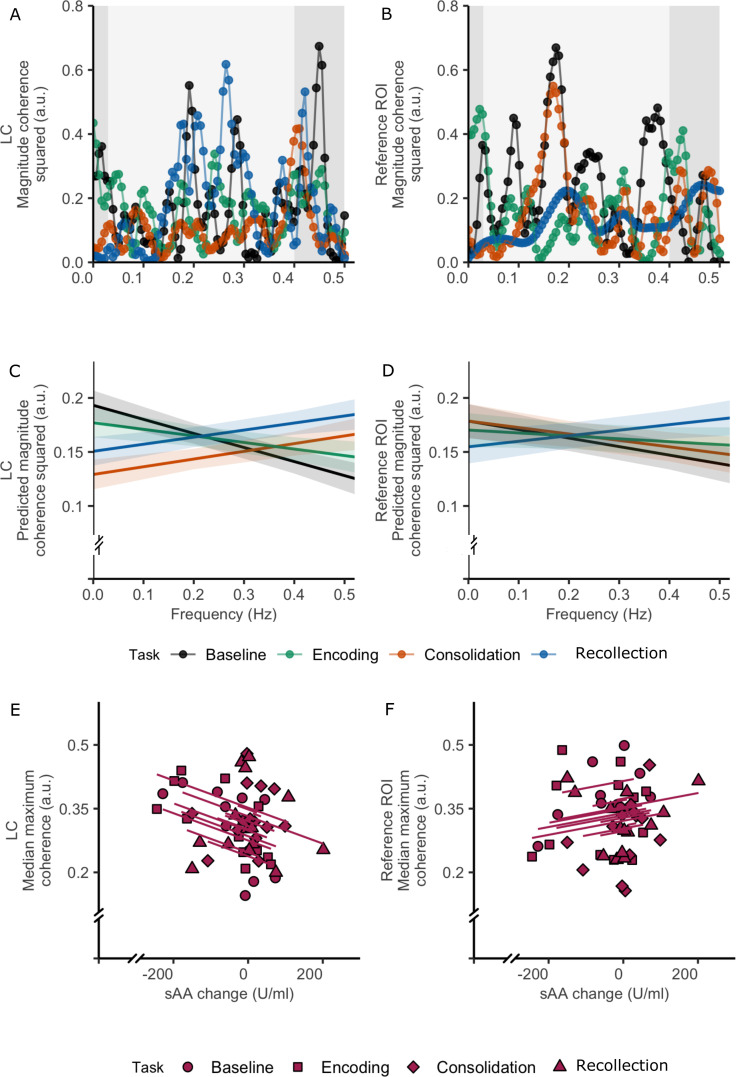
Coherence between LC and HRV across the task stages for the FIXed + Explicit Resp pipeline.Note: Coherence between LC and HRV across the task stages. (A) LC coherence magnitude squared plotted against frequency for each task stage for a single participant. The high-frequency HRV band is depicted in a lighter shade. (B) Reference ROI-HRV coherence magnitude squared for the same participant. (C) The association between frequency and the predicted magnitude squared coherence between the LC and HRV across the various task stages (based on linear mixed effects models,, N = 24 (7920 observations), p-values for all comparisons are provided in Supplementary file 6). Shaded regions in C and D show the 95% confidence intervals. (E) Repeated correlations between LC-HRV coherence and ΔsAA (Rrm(df)=−0.297 (34), p-value=0.078, CI (95%) = [−0.58,0.046], N = 17, 56 observations). (F) Reference ROI-HRV coherence and sAA change levels (not significant, Rrm(df)=0.199 (34), p-value=0.246, CI (95%) = [−0.14,–0.5], N = 17, 56 observations).